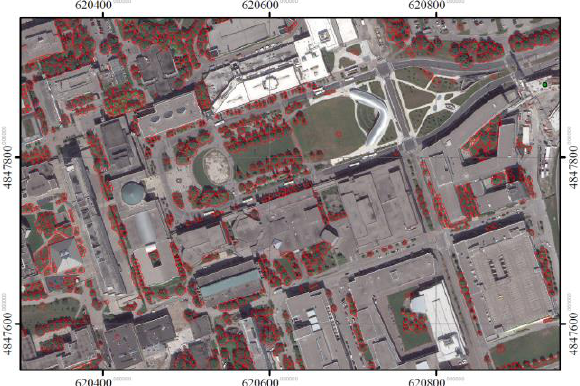
Figure 7: The tree segments for the subset with street trees.